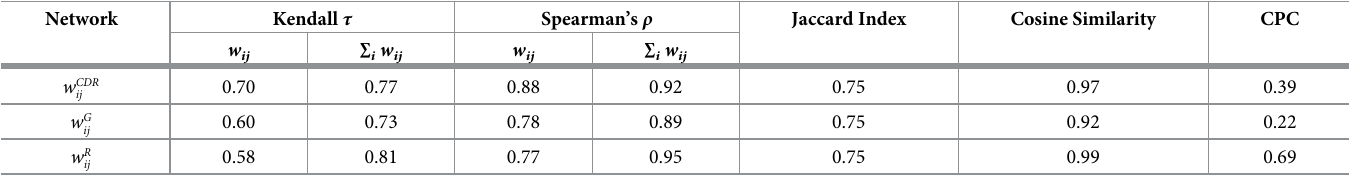
Table 2. Statistical comparison of the mobility networks against the census network. The table reports the values of Kendall’s τ and Spearman’s ρ correlation coefficients (computed both on flows w ij and outflows ∑ i w ij ), the Jaccard index, the cosine similarity, and the common part of commuters (CPC). All p-values are statistically signifi- cant ( p < 0.01).